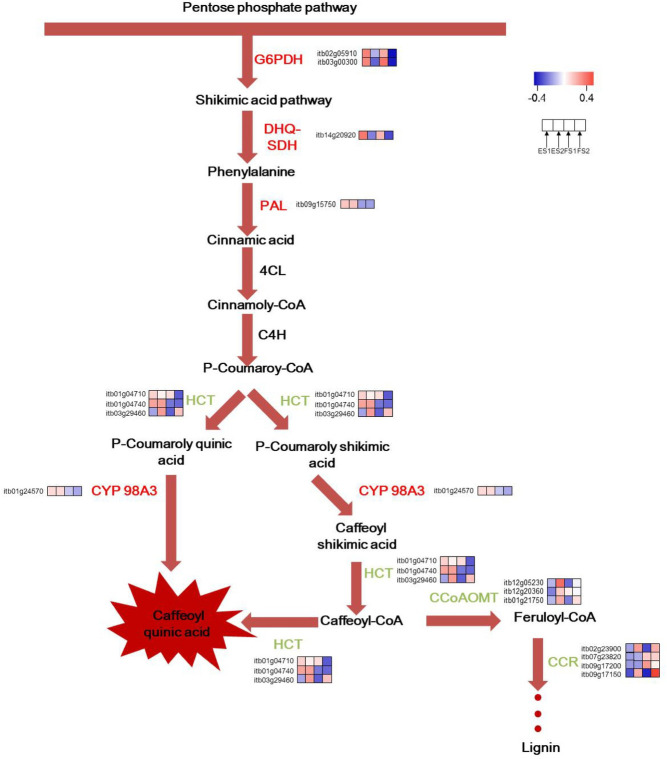
A hypothetical representation of the expression patterns of genes involved in the CGA biosynthetic pathway in leafy sweet potato.Upregulated Genes were shown in red, downregulated genes in green and non-DEGs in black.